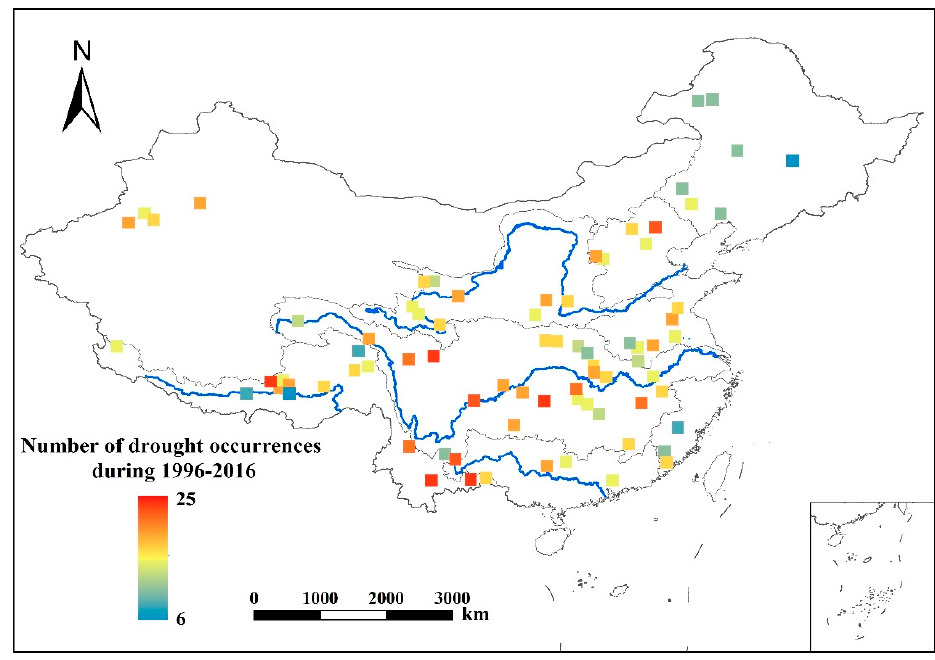
Figure 8. Distribution of drought event frequency for the 79 stations during 1996–2016.